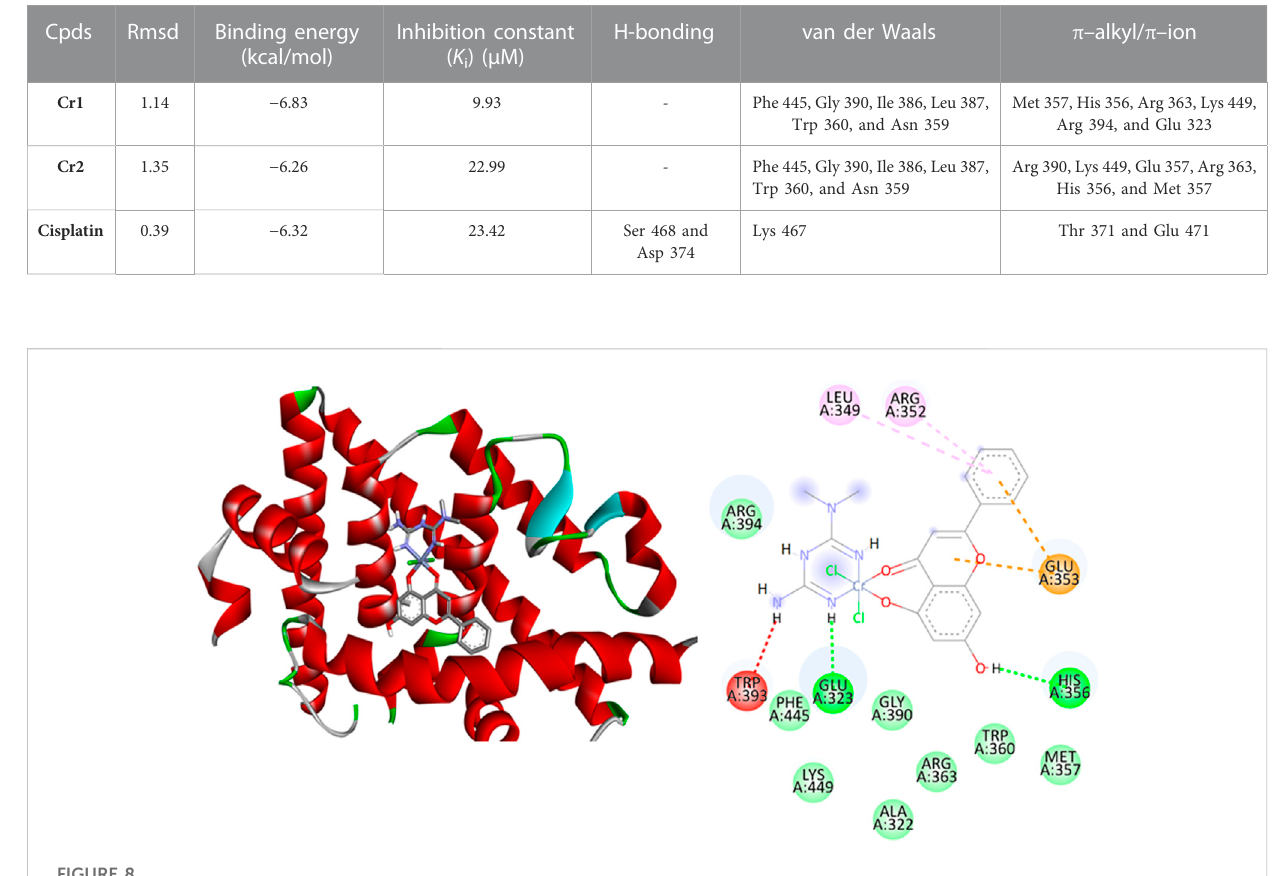
FIGURE 8 Binding interactions of Cr2 against estrogen receptor alpha (ER α ; PDB: